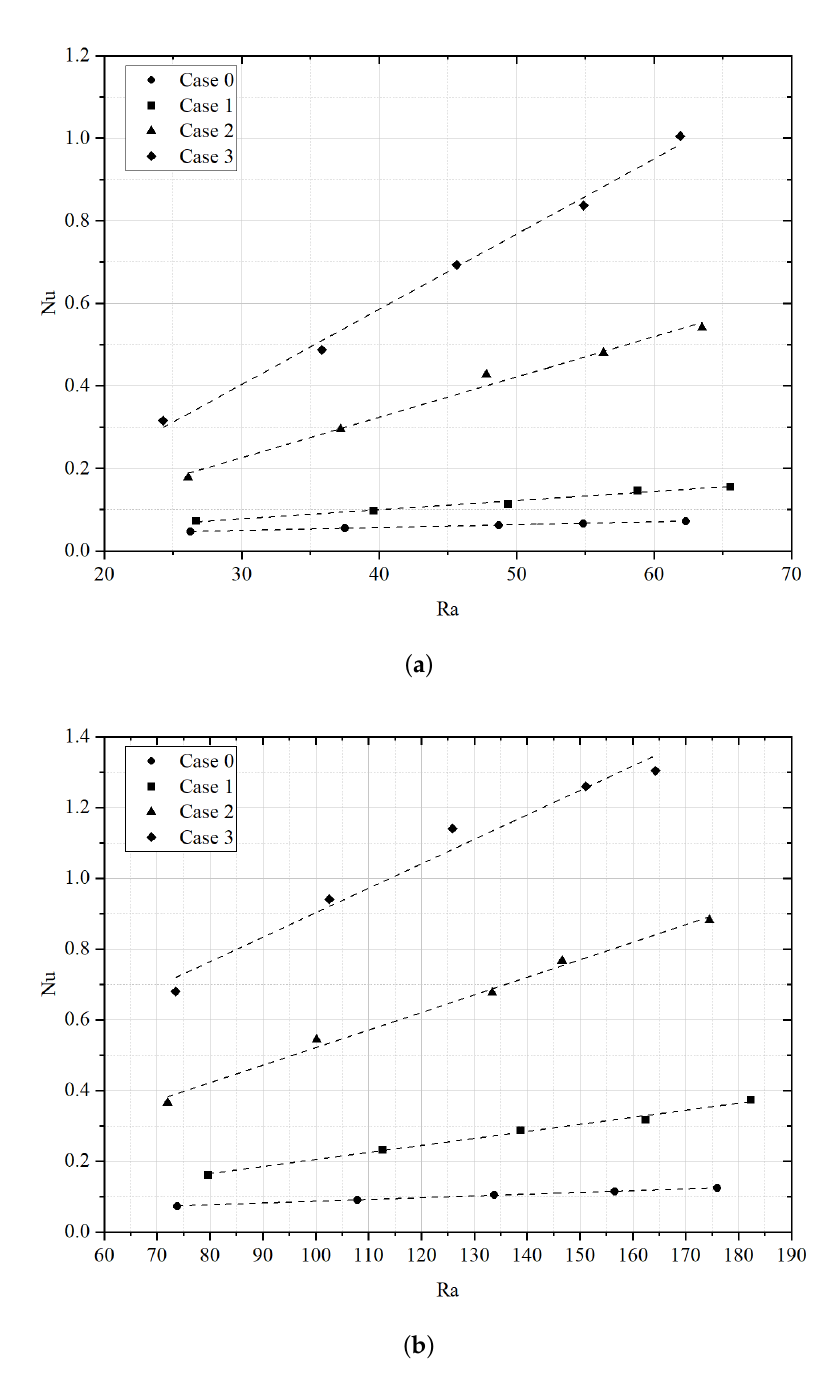
Figure 6. The average Nusselt number for air side as a function of the average Rayleigh numbers for four cases of chimney height. ( a ) Heat exchanger no. 1. ( b ) Heat exchanger no.